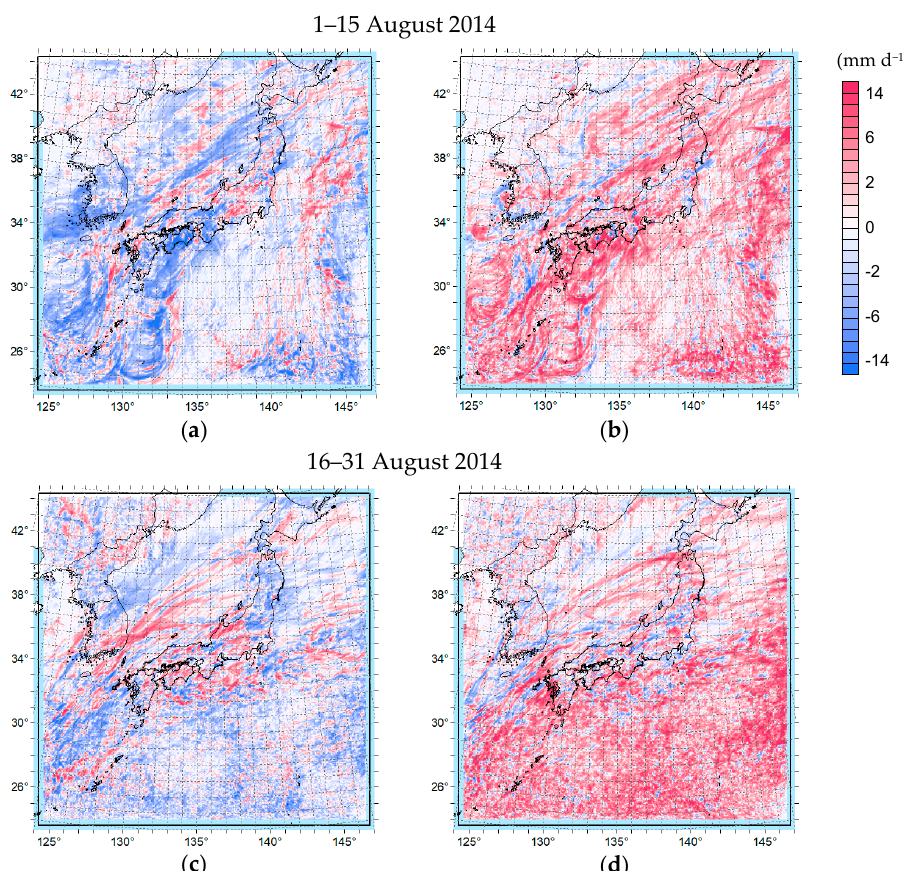
Figure 8. Mean daily precipitation difference from the baseline condition in ( a ) SST − 1 and ( b ) SST+1 conditions during the first half of August 2014, and ( c ) SST − 1 and ( d ) SST+1 conditions during the last half of August 2014.